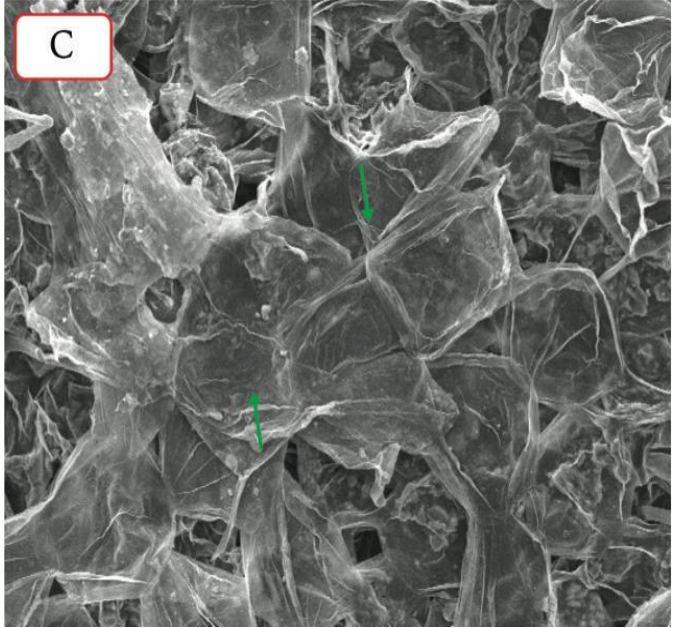
Figure 3. Scanning electron microscope (SEM) images of adaxial (the upper side) leaf surface of ( A ) Limonium axillare (note the blue asterisks as salt glands, red arrows as stomata), ( B ) Avicennia marina (note the blue asterisks as salt glands, with scattered salt crystals), and ( C ) Atriplex spp. (note the green arrows as ruptured salt bladders). Magnification ×400. N. B. Salt glands in A . marina are found on both leaf sides but are more numerous abaxially (lower side), small in number and large in size on the adaxial surface, and the opposite on the abaxial surface.